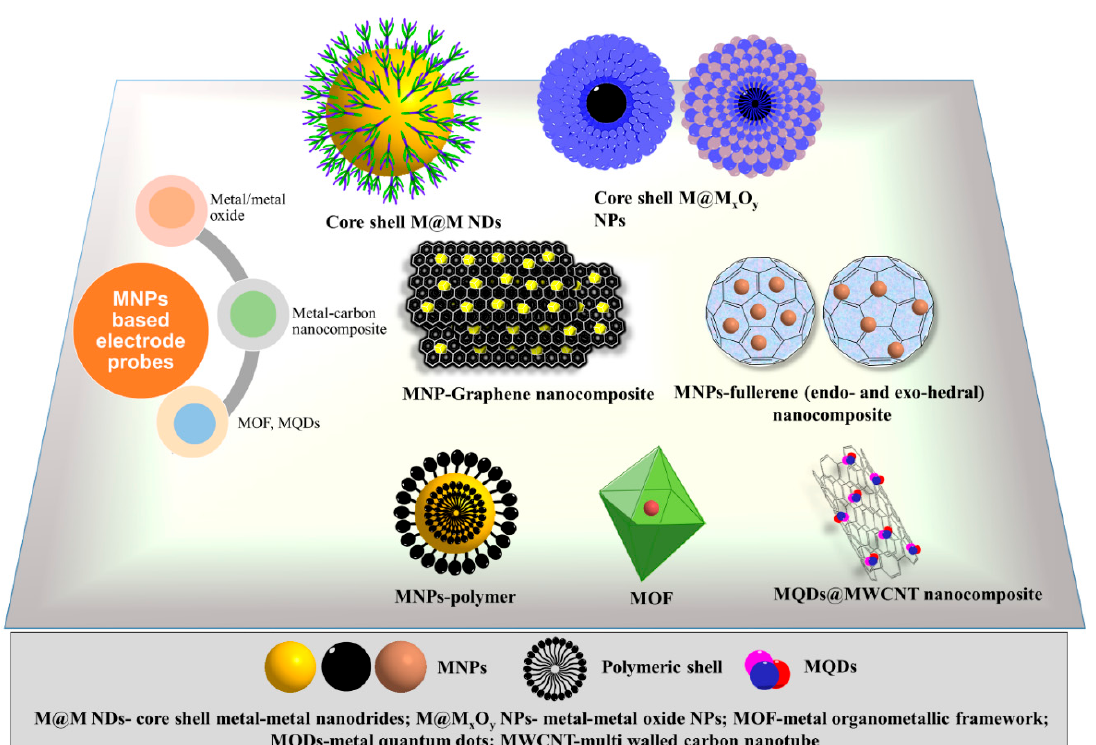
Figure 1. Different metal nanoparticle (MNP)-based composite materials as electrode probes for electrochemical biosensors (ECBs).